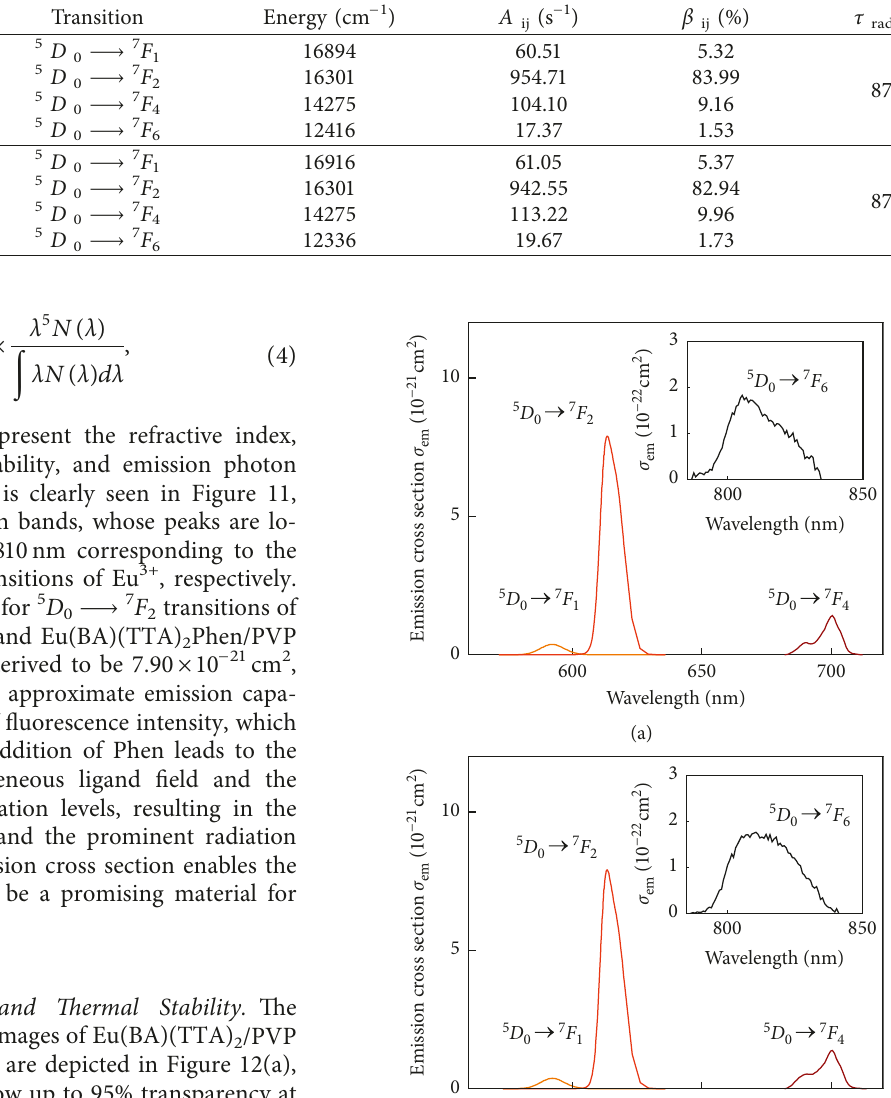
Table 4: Spontaneous transition probabilities A and Eu(BA)(TTA) 2 Phen/PVP.